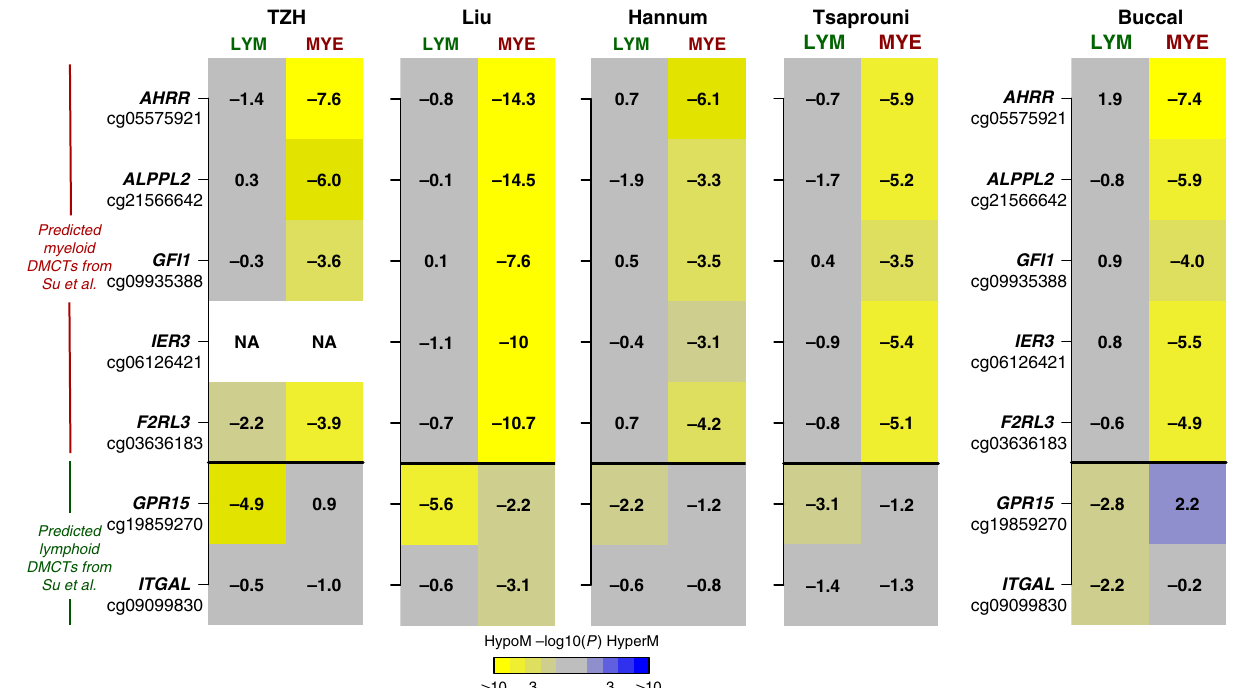
Fig. 3 Validation of CellDMC ’ s predictions. Heatmaps of myeloid and lymphoid signi fi cance P values, as derived from CellDMC, in fi ve separate cohorts and for a panel of seven CpGs which Su et al. showed to exhibit myeloid and lymphoid speci fi c hypomethylation in smokers. The fi rst four cohorts are whole blood samples. Signi fi cance of P values is denoted by color, and the corresponding t -test statistic values are displayed in the heatmap. P values derive from the t -test in the CellDMC model and are